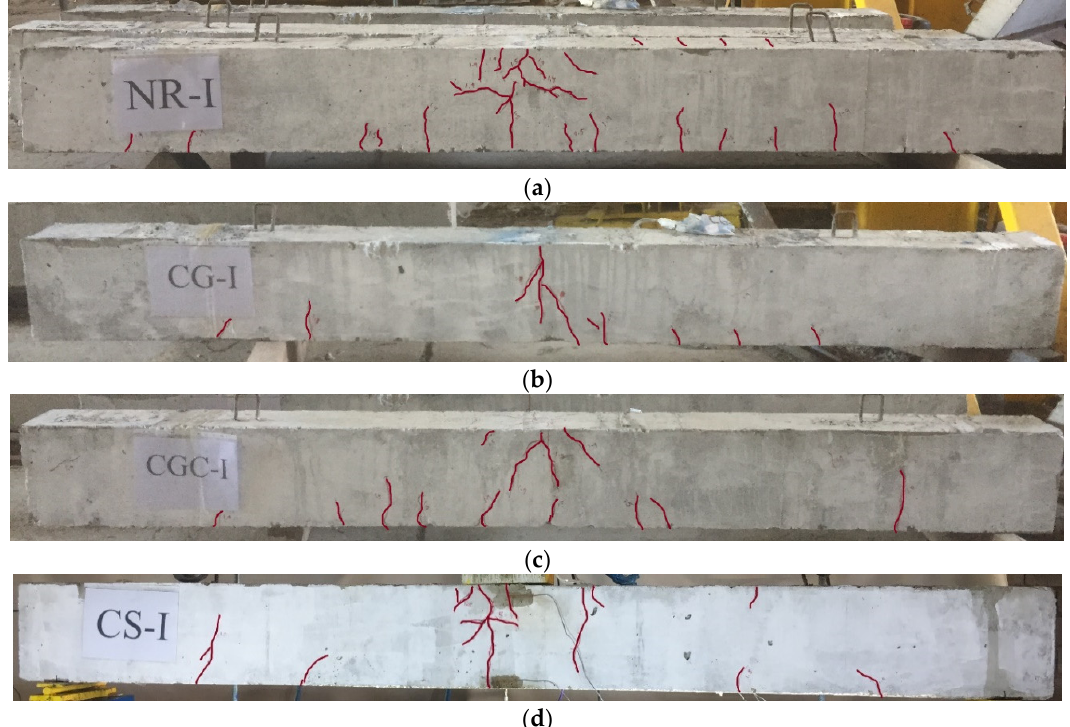
Figure 7. Crack patterns on the side face of the impacted specimens: ( a ) NR ‐ I; ( b ) CG ‐ I; ( c ) CGC ‐ I; ( d ) CS ‐ I.